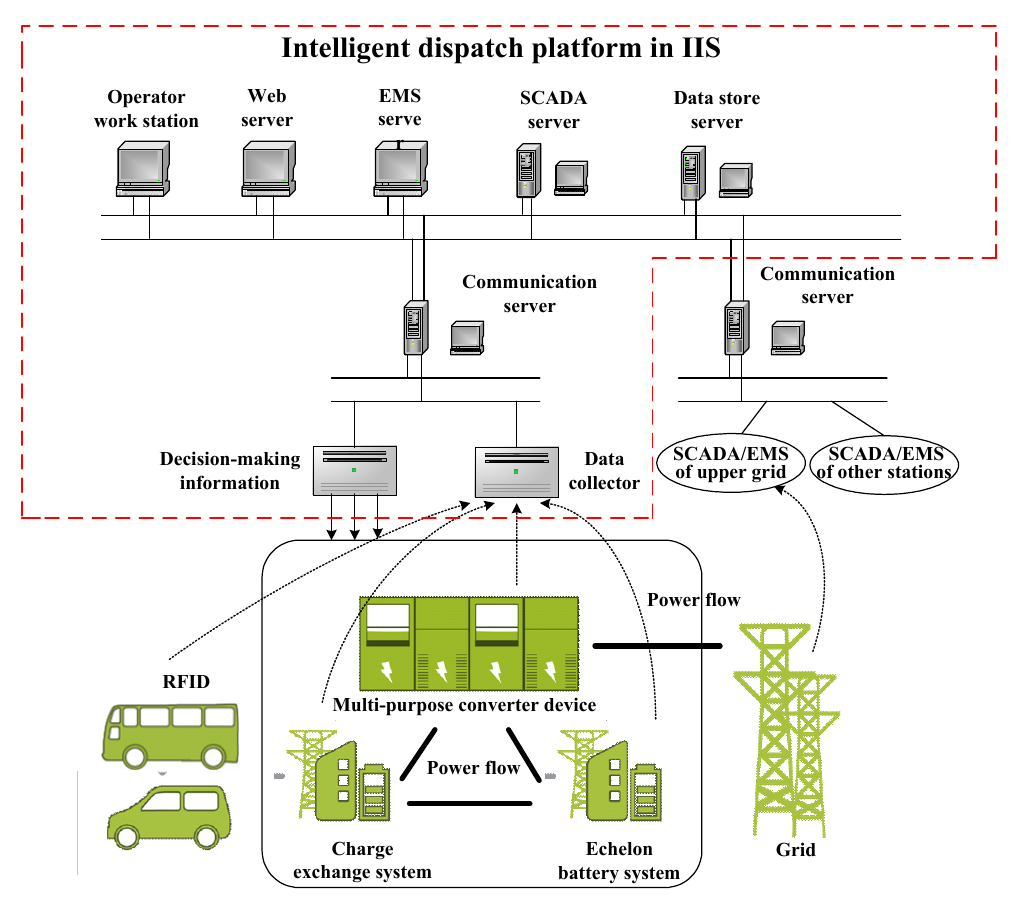
Figure 2. Intelligent dispatching of